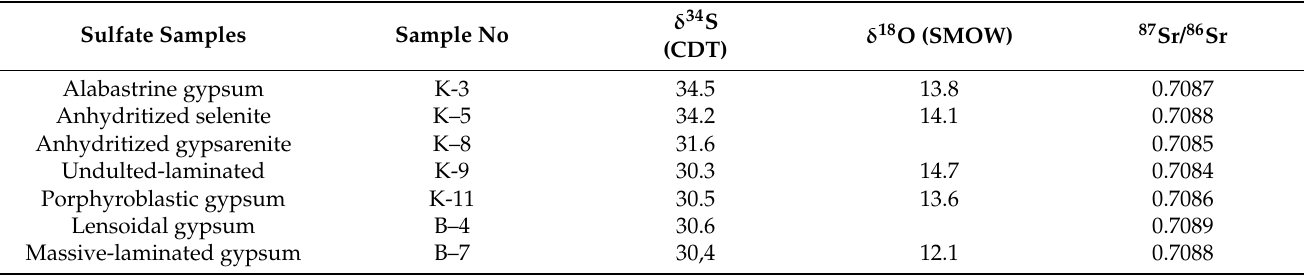
Table 2. Isotope values ( δ 34 S, δ 18 O and 87 Sr/ 86 Sr) of different evaporite rock samples intercalated with clay-carbonate.